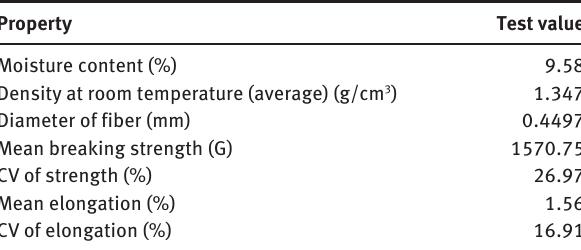
Table 2 Properties of jute